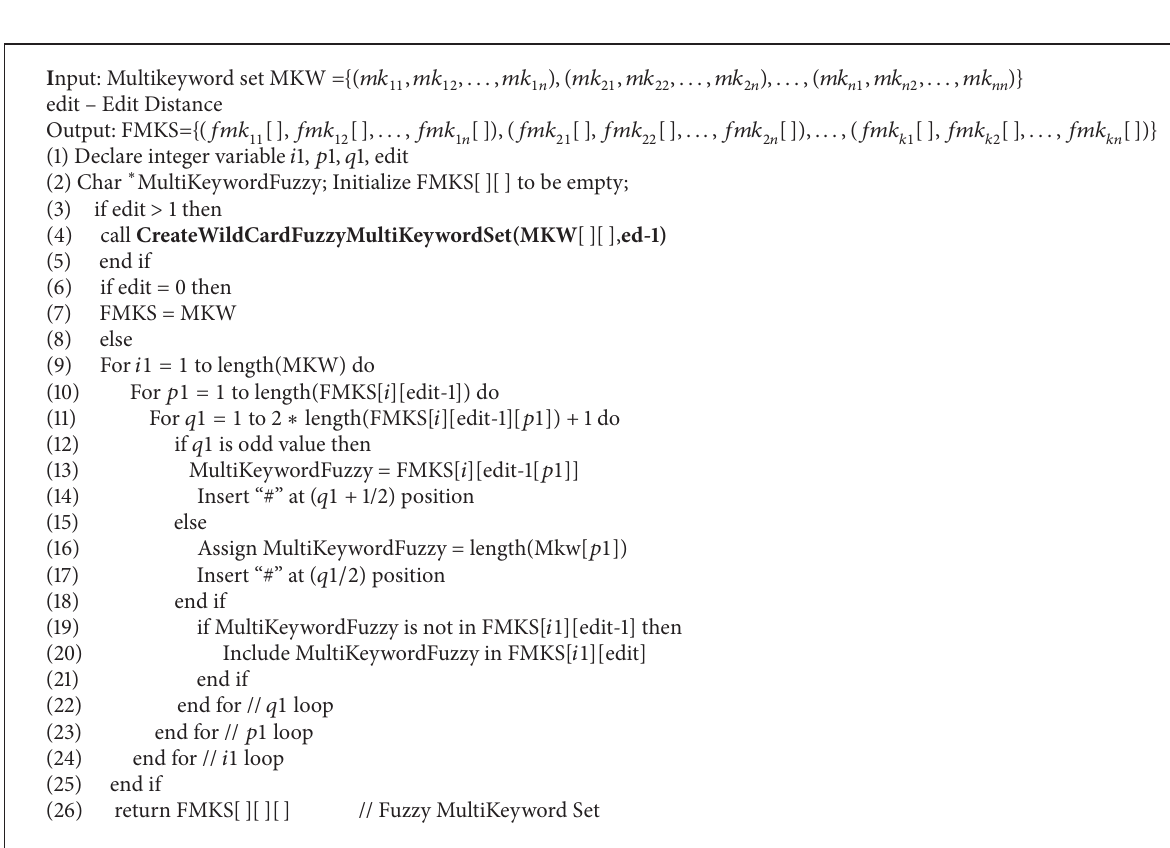
) // File Decryption ENC